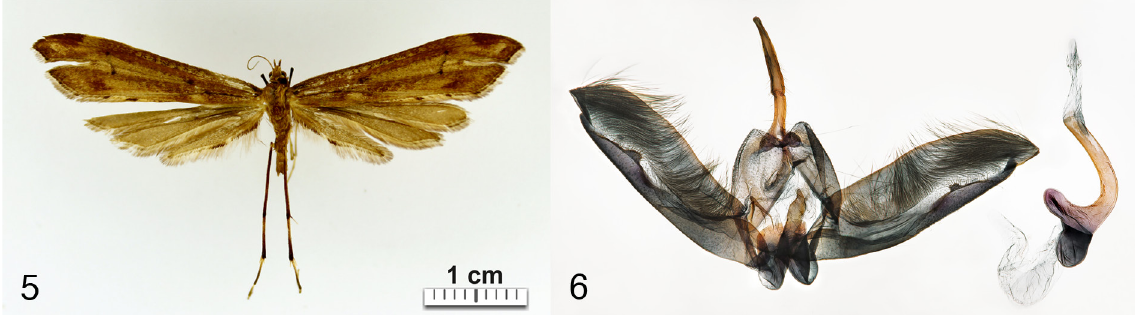
Figs 5-6. Platyptilia stanleyi Ustjuzhanin & Kovtunovich sp. nov., holotype, ♂ (BMNH 21803). 5 . adult, habitus. 6 . Male